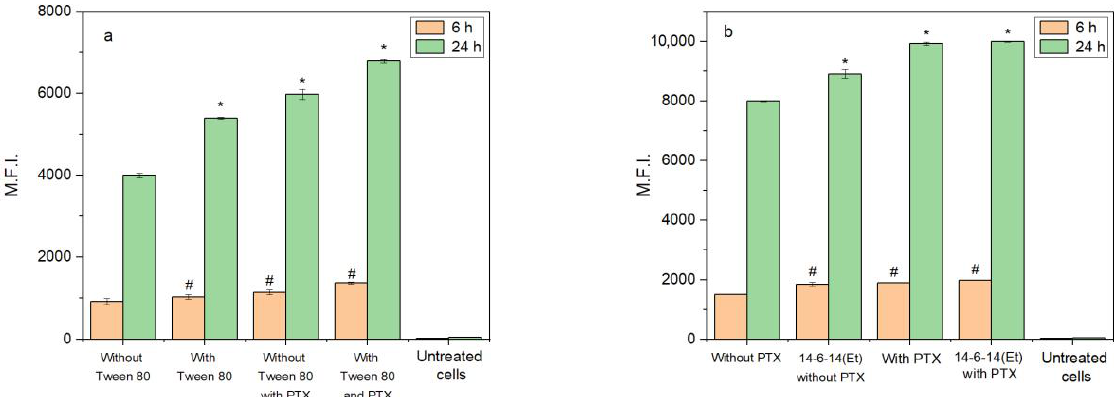
Figure 5. Cellular uptake of cerasomes with and without PTX evaluated using flow cytometry at 6 h and 24 h of incubation: ( a ) comparison of 10% Tween 80 effect on 50% CFL 50% PC cerasomes; (b) comparison of 14-6-14(Et) effect on 50% CFL 50% PC cerasomes with additional 10% Tween 80. * — p < 0.01 comparing samples at 24 h; # — p < 0.01 comparing samples at 6 h. Comparisons were made with first sample in each group.